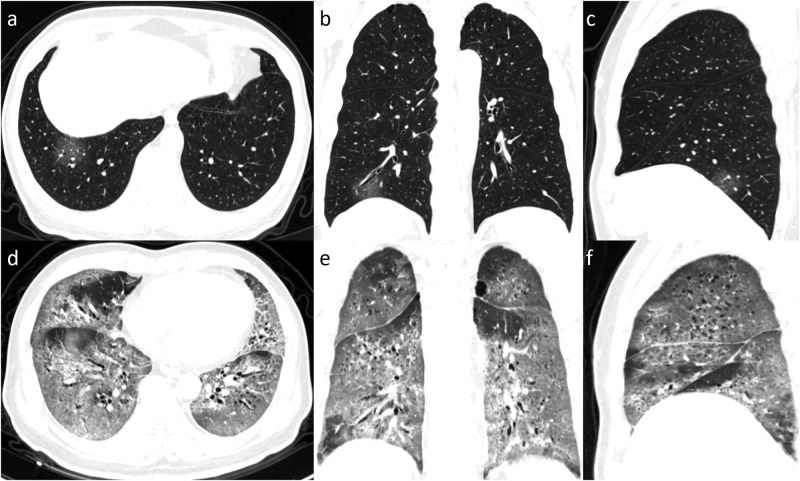
Serial chest images of a 59-year-old man with fever, dyspnea, and dry cough.(a-d) 17 days before death, chest CT with axial, coronal, sagittal planes showed minimal lung involvement with a total CT score of 1, a small piece of ground-glass opacity was found in the right lower lobe. (e-f) 10 days before death, chest CT with different planes showed severe lung involvement with a total score of 19, with an appearance of the white lung.